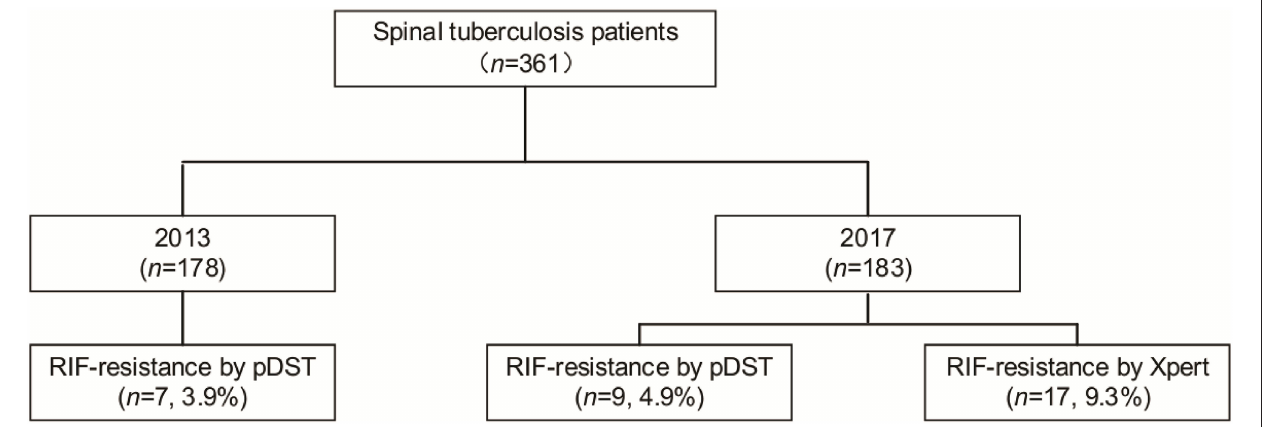
FIGURE 1 | Comparison of patients with rifampicin (RIF)-resistant spinal tuberculosis between 2013 and 2017.